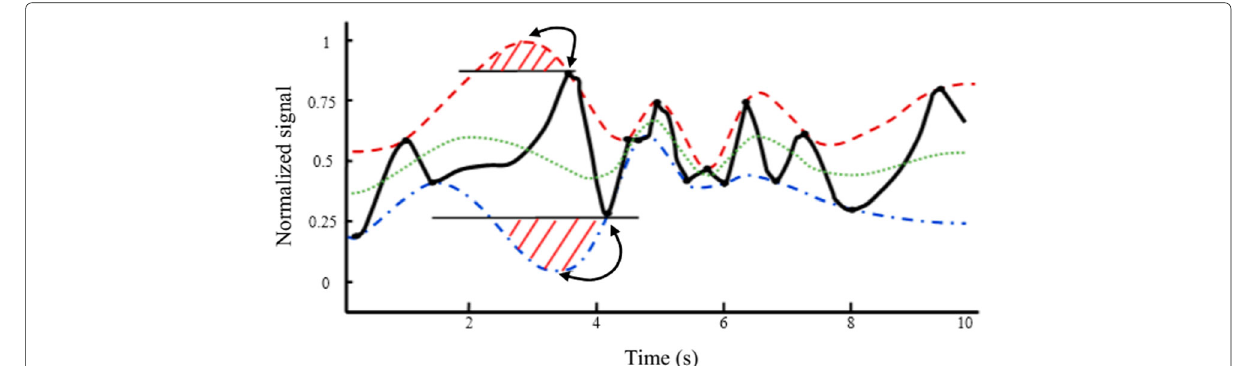
Fig. 11 Demonstration of overshoot and undershoot problems related with EMD